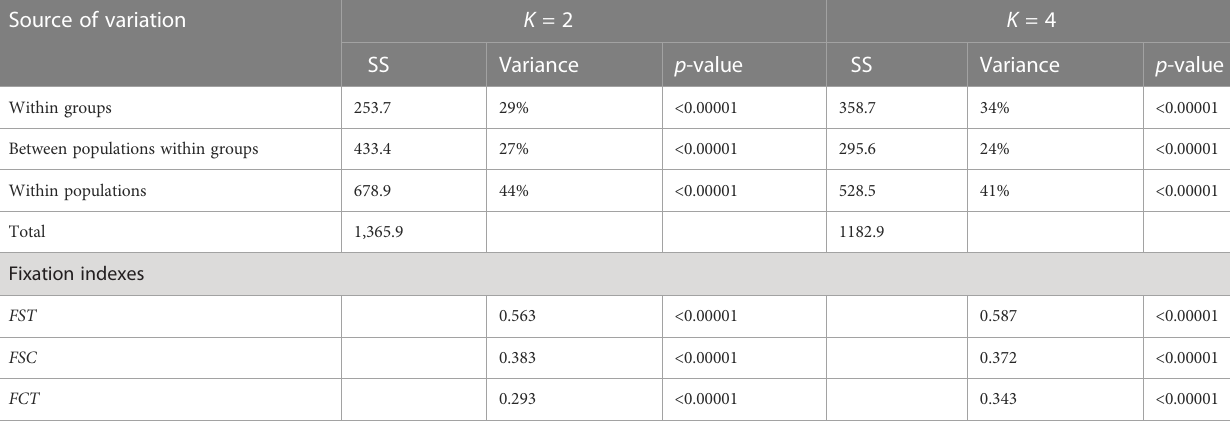
TABLE 5 AMOVA and fi xation indexes for the analysis of SSR diversity among tomato